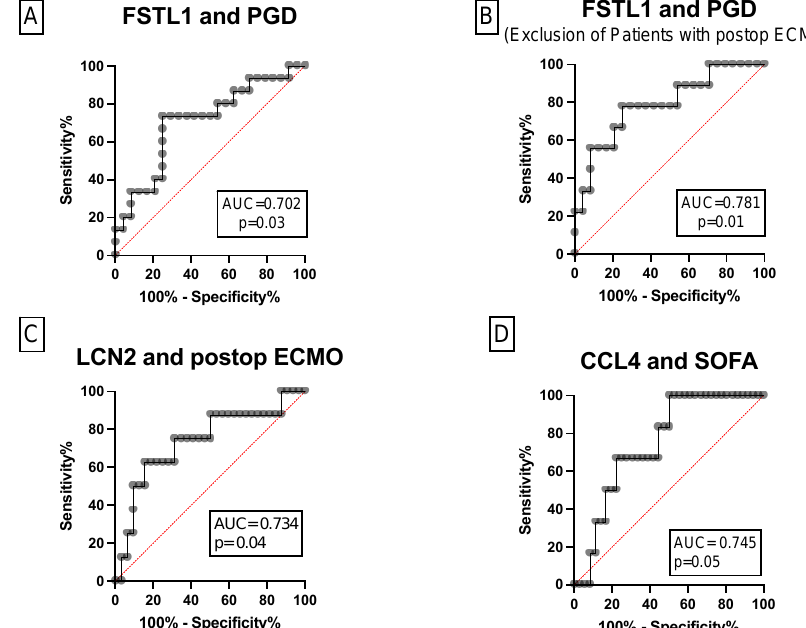
Figure 3. ROC curves of LCN2, CCL4 and FSTL 1. ( A , B ) FSTL1 FI discriminates between patients with and without PGD after LuTX even after exclusion of patients requiring postoperative ECMO support. ( C ) LCN2 FI discriminates between patients with and without prolonged ECMO support. ( D ) CCL4 FI discriminates between patients with a clinically increased inflammatory status, tangible as a SOFA score >13 and those with a SOFA < 13. CCL4, chemokine 4; ECMO, extracorporeal membrane oxygenation; FI, fold increase; FSTL1, follistatin-like 1; LCN2, lipocalin 2; LuTX, lung transplantation; PGD, primary graft dysfunction; ROC, receiver operating curve; SOFA, sequential organ failure assessment score.